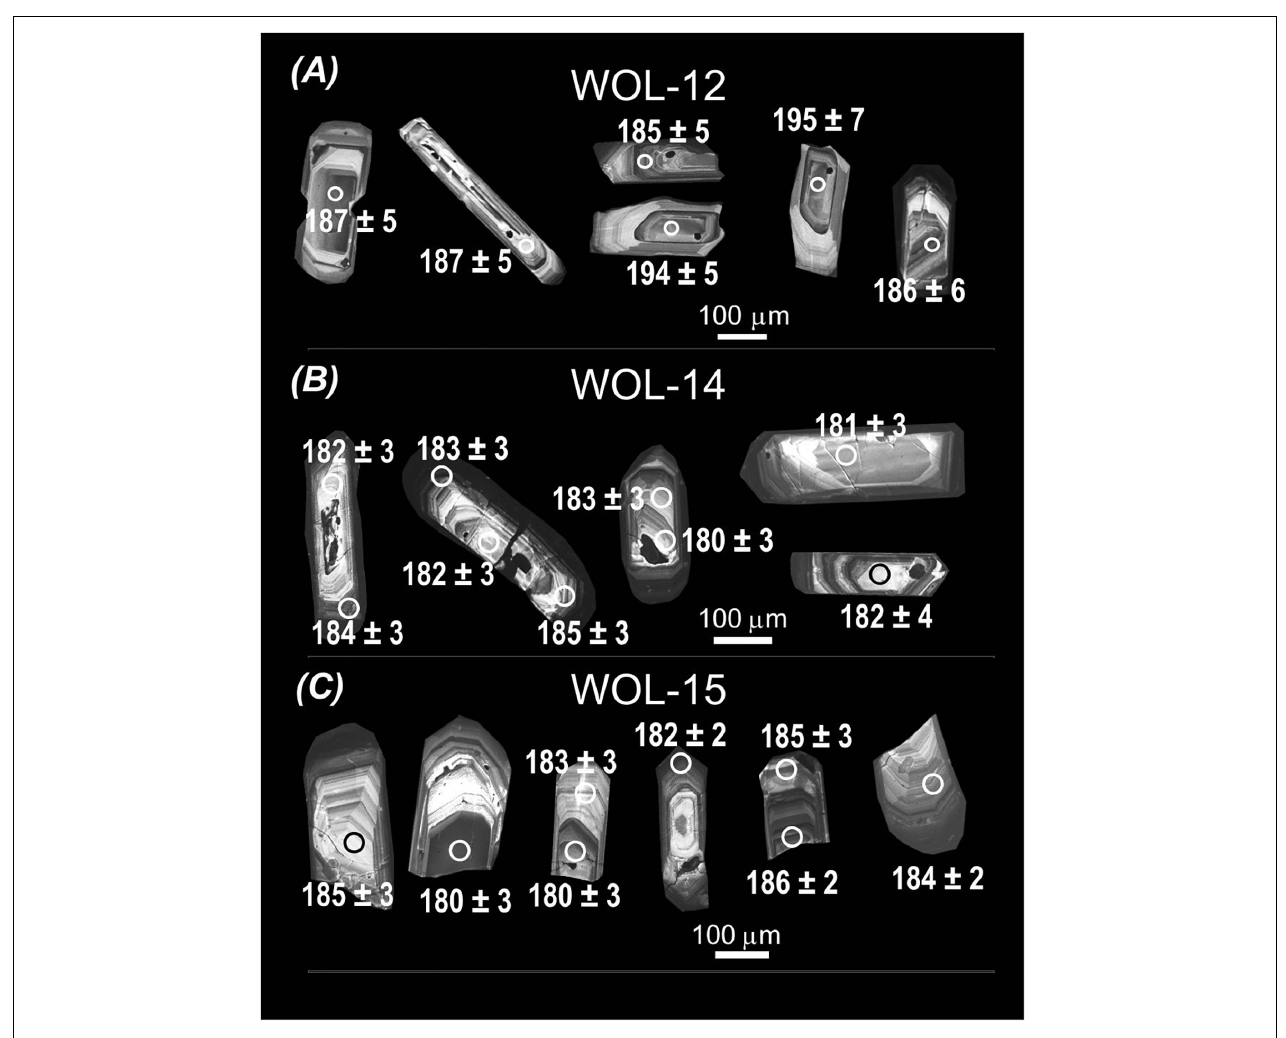
FIGURE 6 | Representative cathodoluminescence images of the dated zircons grains. The spots (25 µ m) where laser ablation analysis was performed are indicated together with obtained 206 Pb/ 238 U ages in Ma ( ± 2 σ uncertainties). (A) zircons from sample WOL-12; (B) zircons from sample WOL-14; (C) zircons from sample